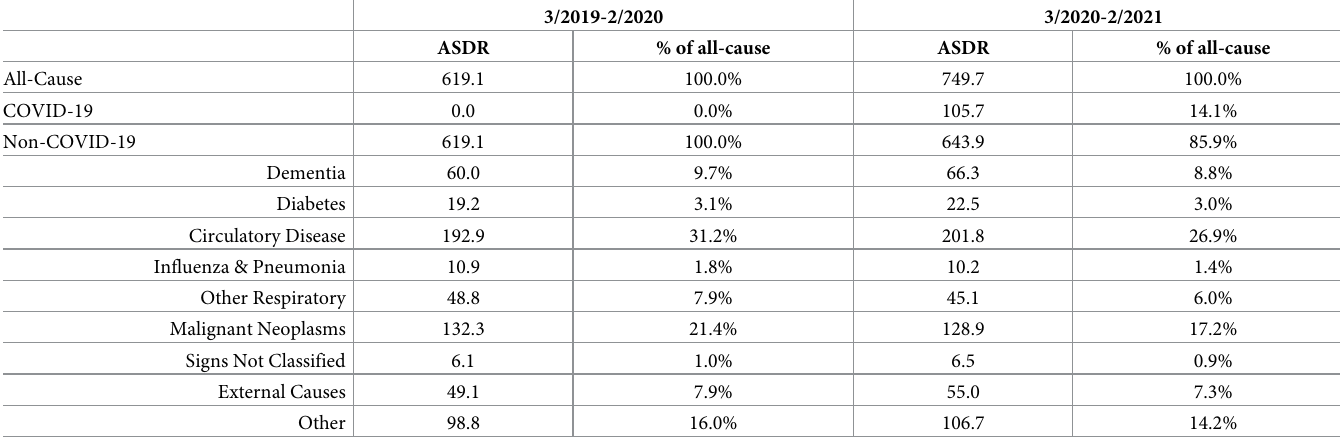
Table 1. National distribution of all-cause mortality by select causes of death, ages